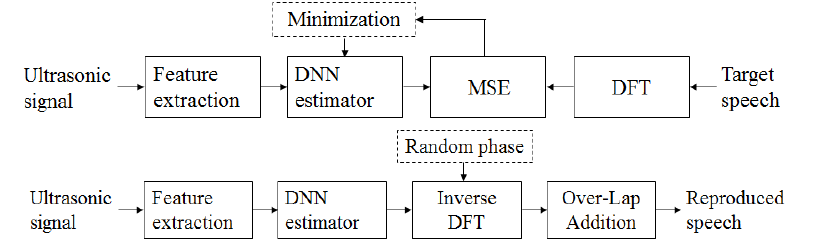
Figure 1. Block diagram of the baseline ultrasonic SSI system. ( Top ): Training procedure. ( Bottom ): Synthesis